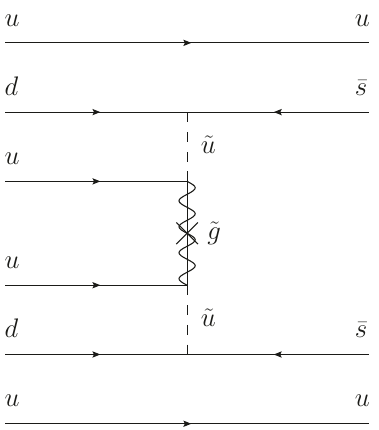
Figure 2. Diagram mediating the pp ! K + K +